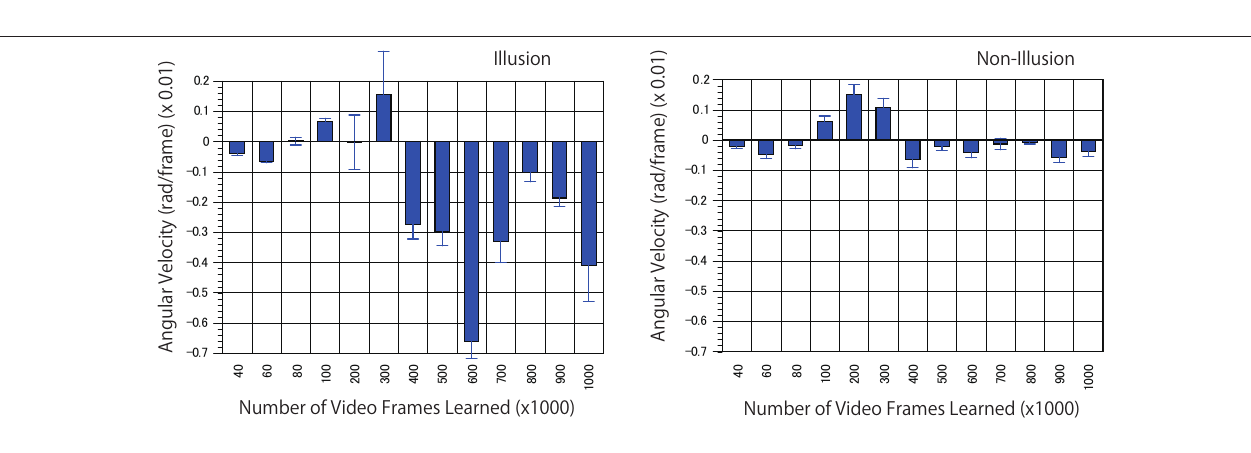
FIGURE 8 | Predicted motion found in the illusion. Optical flow vectors detected between a pair of consecutive predictive images (P1/P2) of the illusion. The mean angular velocity was calculated from the optical flow vectors. A positive sign was assigned to clockwise rotation. One hundred optical flow vectors were detected in each pair of images. Error bars indicate standard errors. Although the reason was unknown, unidirectional optical flows were observed in a wide area of the predicted images from 100 to 300K. The magnitude of optical flows was biased by location. The apparent positive angular velocities from 100 to 300K appeared to be caused by the